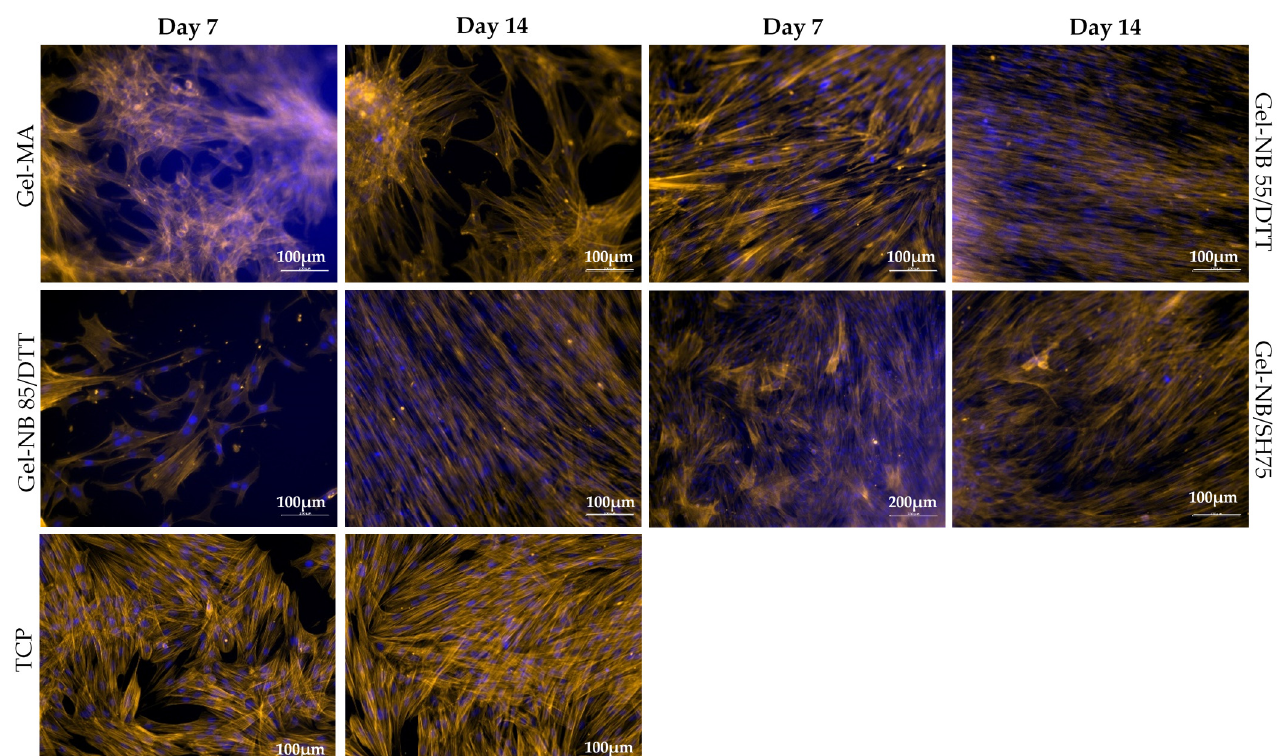
Figure 6. Representative images of the qualitative evaluation of tenocyte morphology and cell alignment based on fluorescent staining of the actin filaments (orange) with DAPI nuclear counterstaining (blue). Experiment was performed in triplicate. Tenocytes should be spindle-shaped, elongated and organized in a parallel fashion (as seen on gel-NB55/DTT days 7 and 14, and gel-NB85/DTT day 14). A rounder cell morphology on gel-MA discs is seen (both timepoints) and an intermediate morphology (between round and spindle-shaped) on TCP and gel-NB85/SH75 (both timepoints). DTT: 1,4-dithiotreitol; gel-MA: methacrylated gelatin; gel-NB: norbornene-functionalized gelatin; gel-SH: thiolated gelatin; TCP: tissue culture plastic.